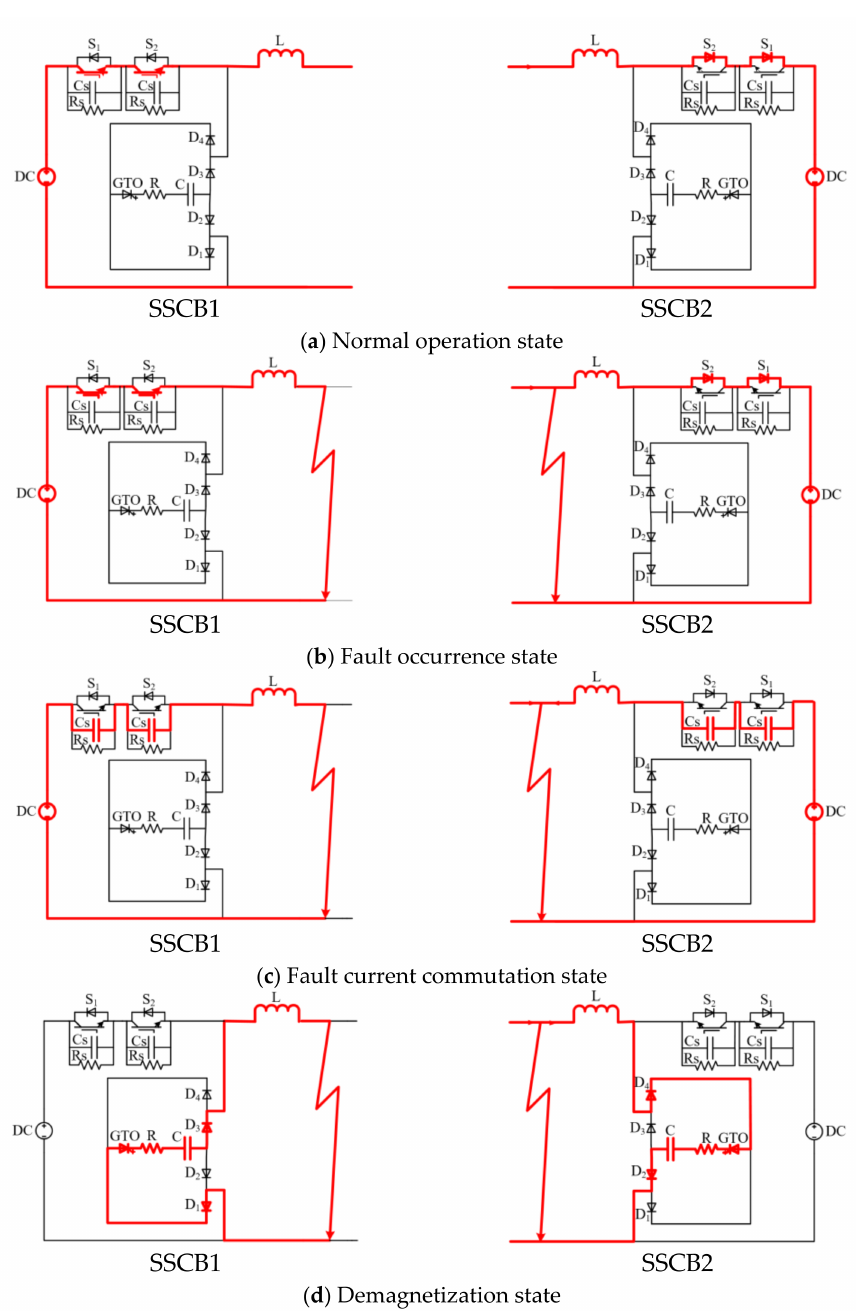
Figure 14. Operation principles of proposed SSCB at both